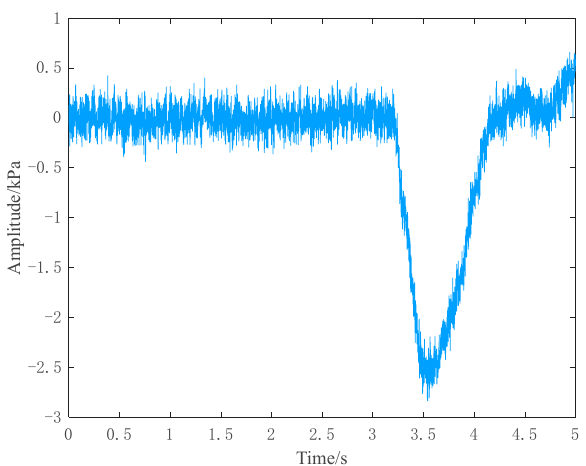
Figure 9. Signal curve after denoising by the UPLCD method.